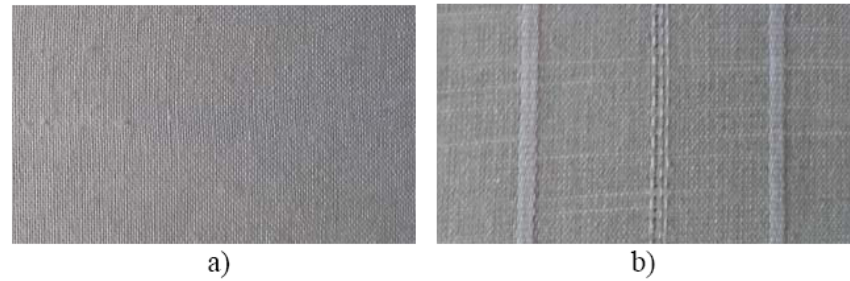
Figure 2. Used flax fabrics: ( a ) 20% cotton and 80% flax; ( b ) 40% cotton and 60% flax.